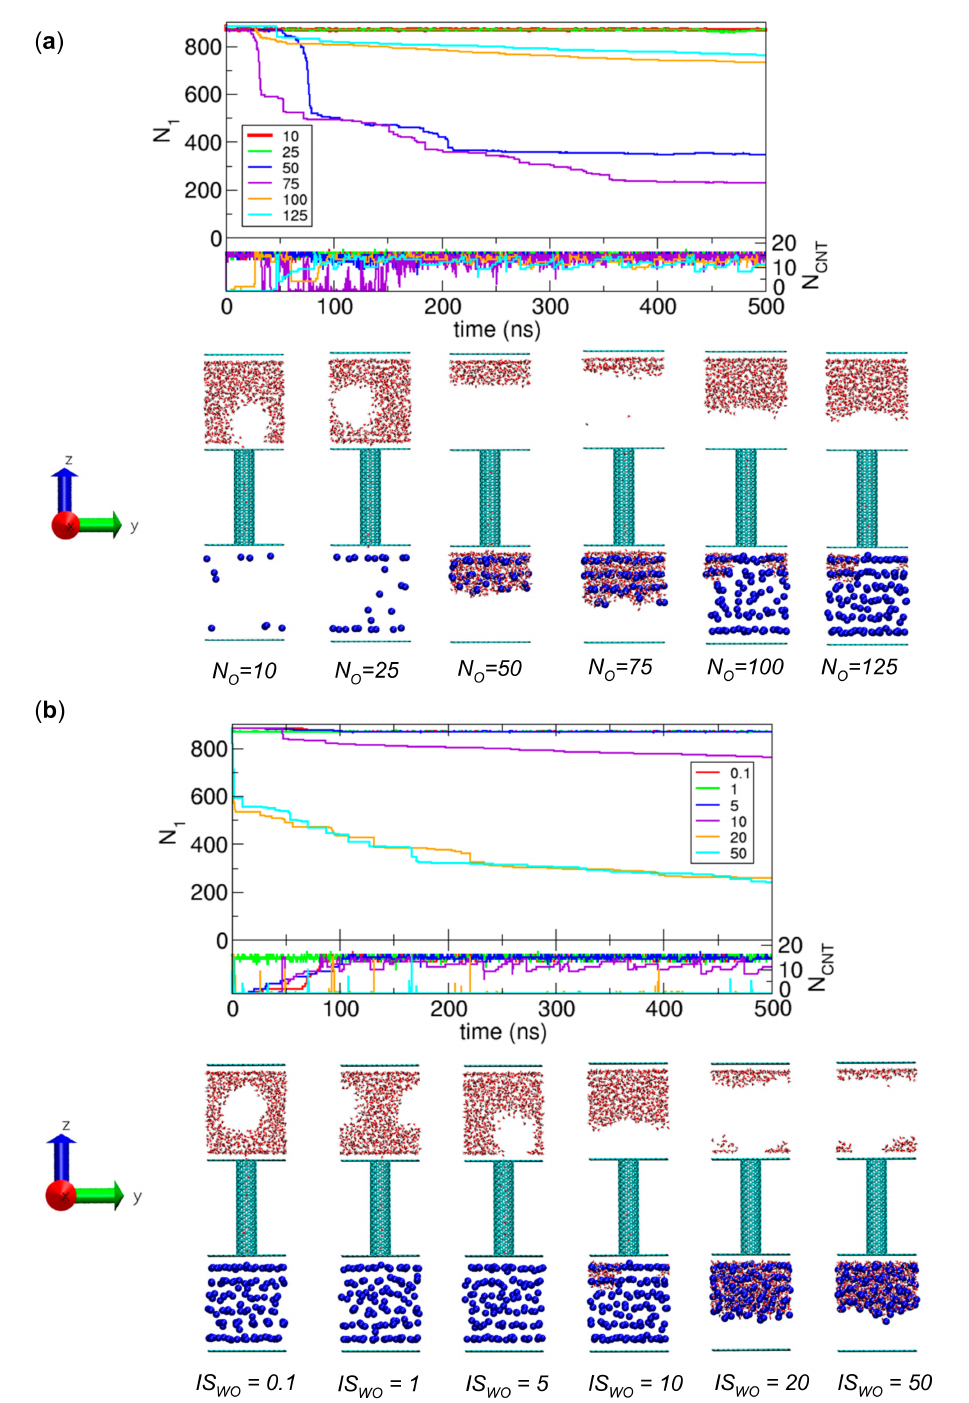
Figure 3. Influence of osmolytes on water transport. ( a ) Numbers of water molecules in Compartment 1 ( N 1 ) and the CNT ( N CNT ) as functions of time for the cases with IS WO = 10 and N O = 10 (red), 25 (green), 50 (blue), 75 (violet), 100 (orange), and 125 (cyan), and their final configurations at 500 ns. ( b ) Numbers of water molecules in Compartment 1 ( N 1 ) and the CNT ( N CNT ) as functions of time for the cases with N O = 125 and IS WO = 0.1 (red), 1 (green), 5 (blue), 10 (violet), 20 (orange), and 50